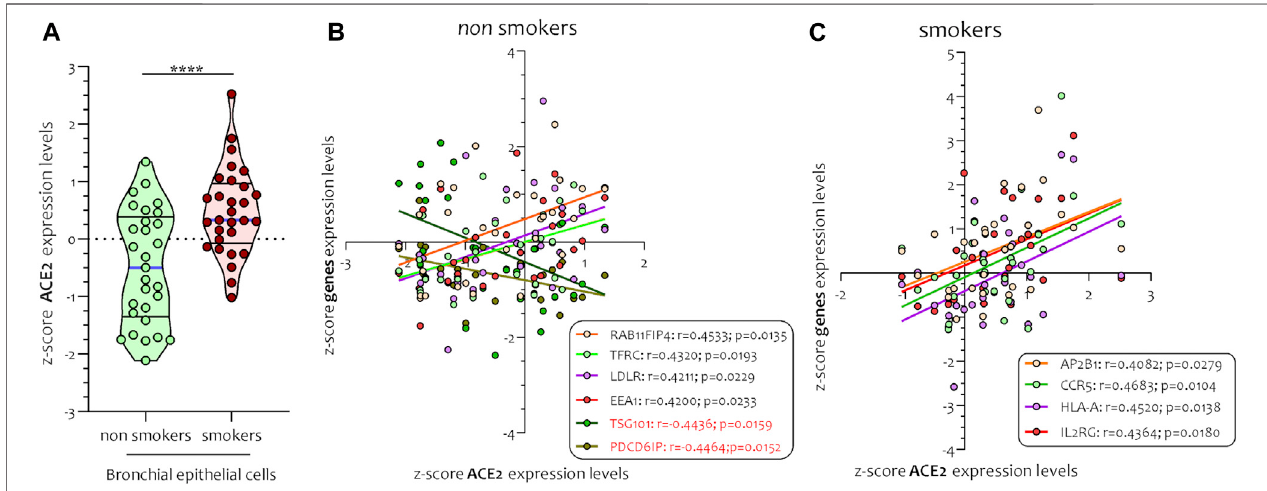
FIGURE 7 | Expression levels of ACE2 (A) and Pearson ’ s correlation analysis between ACE-2 and nAChR (CHRNA7) z-score mRNA expression levels in smokers (B) and non-smokers (C) small airways epithelial (SAE) cells. Data are expressed as dot plot.